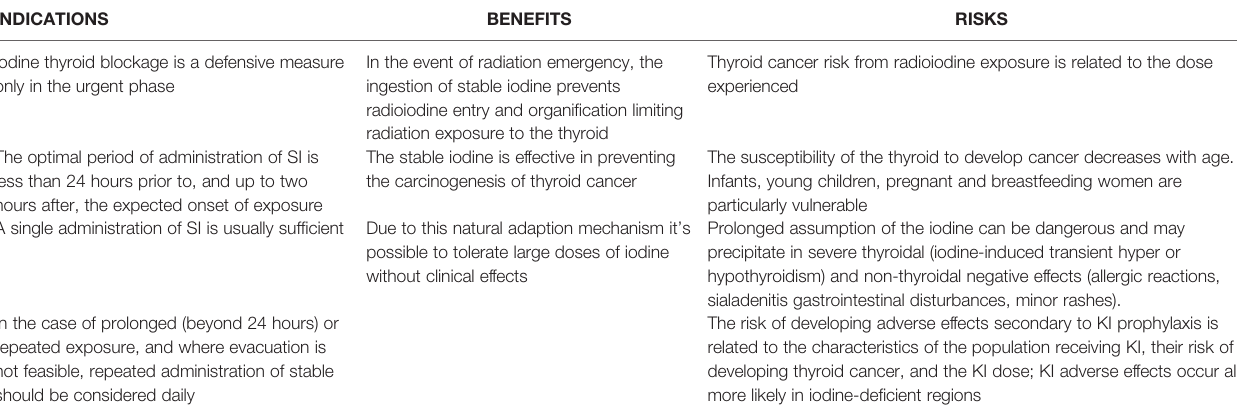
TABLE 6 | Indications, bene fi ts, and risk of iodine thyroid blockage in case of nuclear